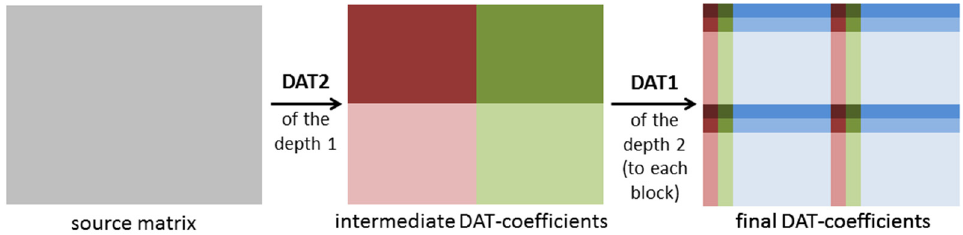
Figure 8. A structure of the matrix transform DAT2 of the depth n.